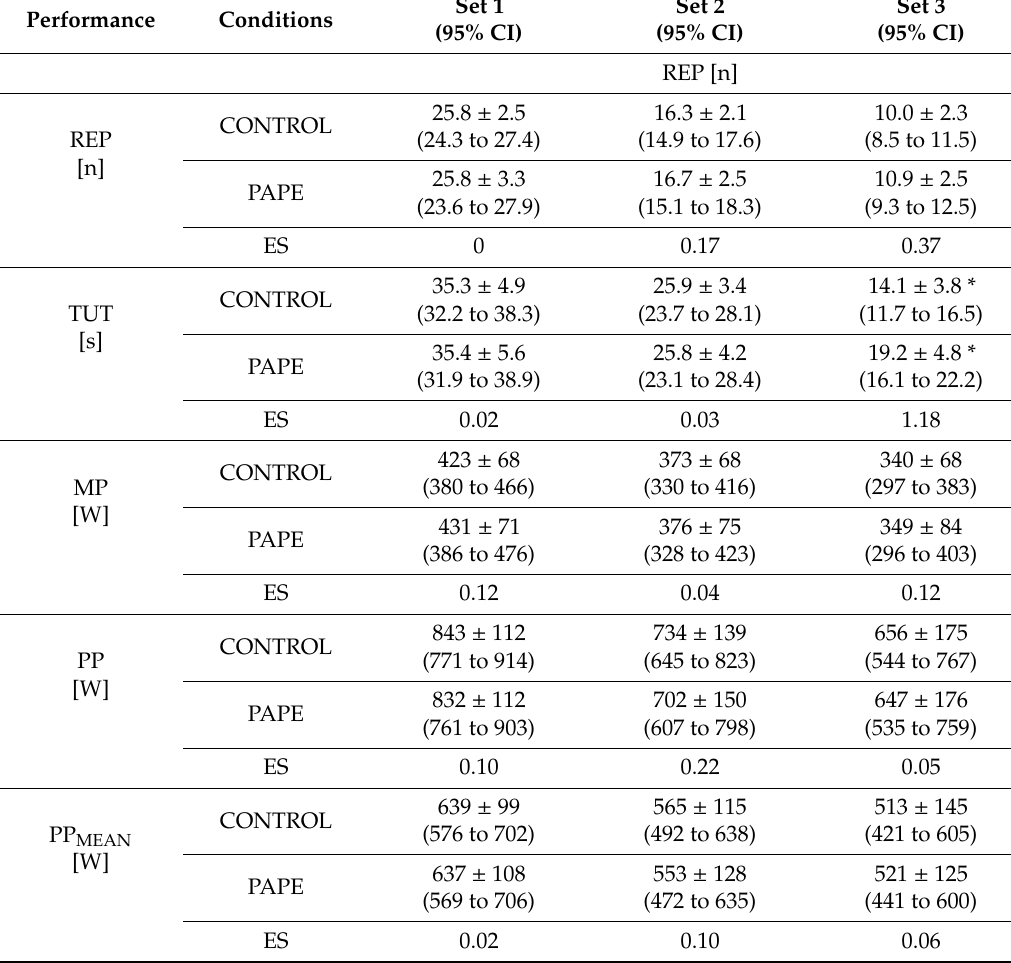
Table 2. Performance variables for particular sets of the bench press exercise.